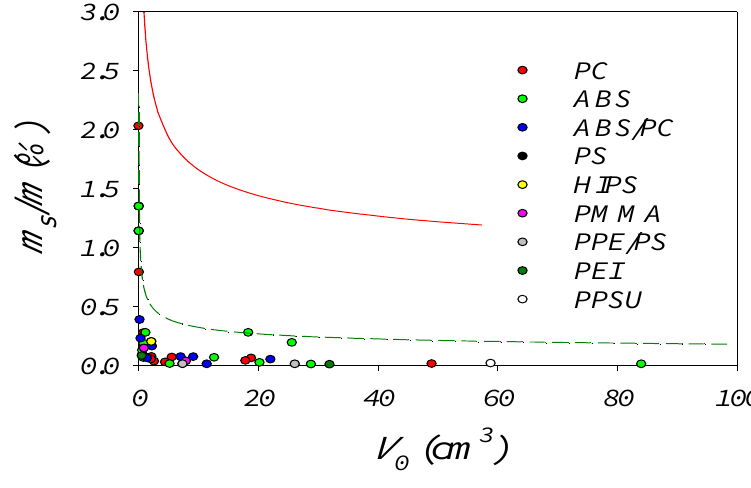
Figure 1. The relative standard deviation of the part weight of all single sets of parts m  /m versus part volume